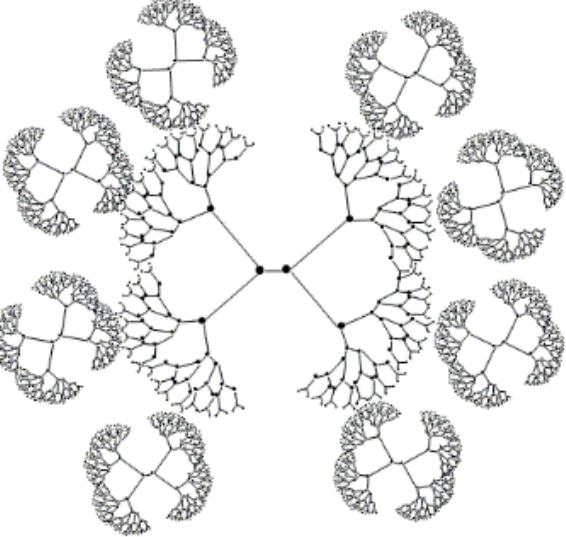
Figure 2. Schematic representation of a PAMAM core–shell TECTO dendrimer. Peptide